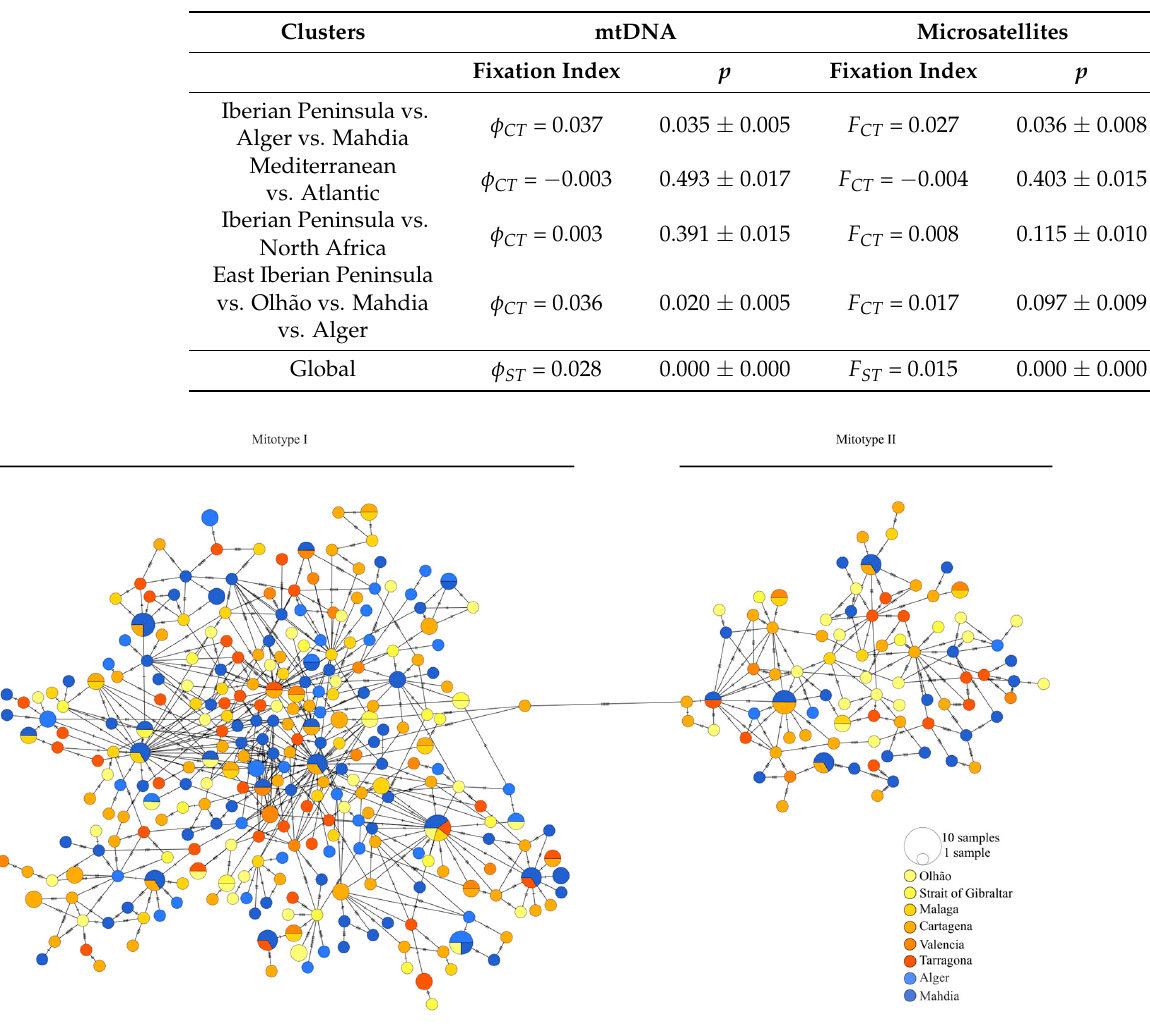
Table 3. Summary of φ and F-statistics obtained from AMOVA to test the best clustering model for both mtDNA and Microsatellites.